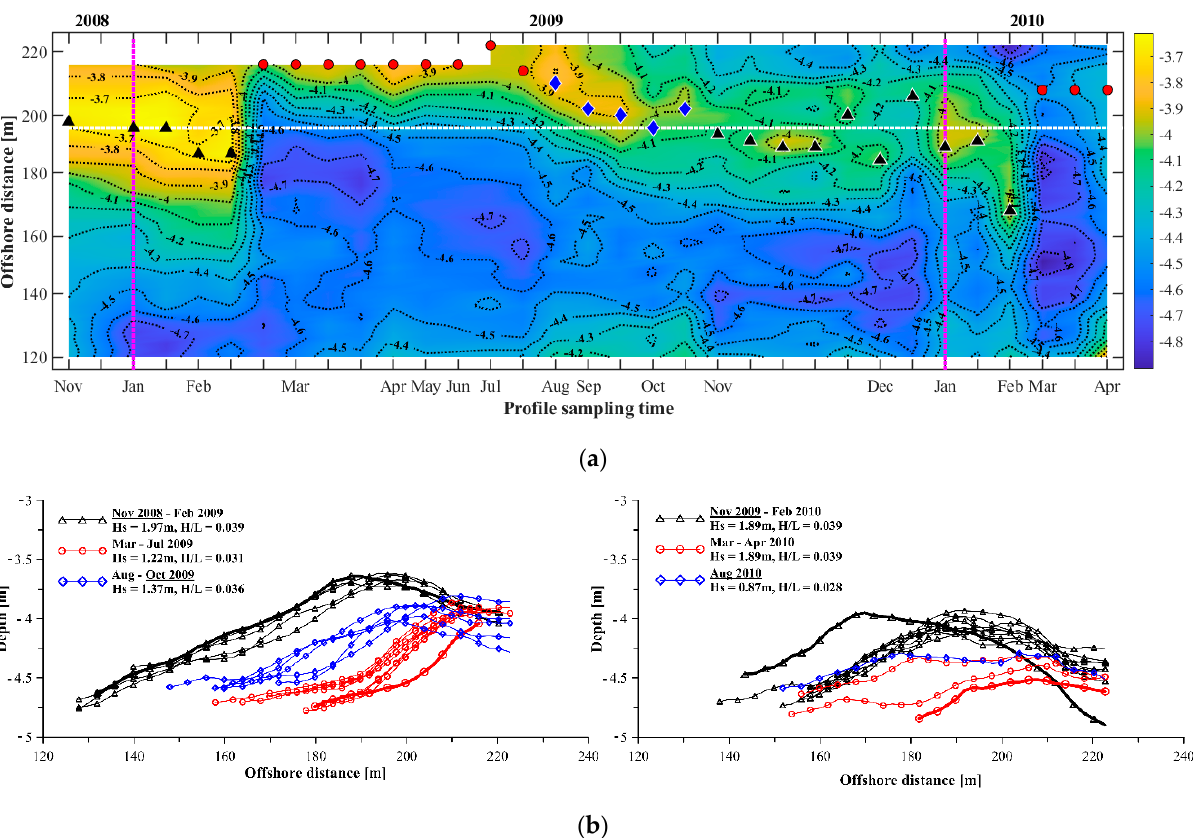
Figure 3. Intra-annual morphodynamics of the outer sand bar: ( a ) chronological seabed relief changes in November 2008–April 2010; colors and symbols of bar crest positions correspond to profile groups as described below in the caption text; vertical magenta lines—beginning of each year, horizontal white line—reference winter bar crest location defined from 2009 data; ( b ) outer bar profile envelopes of temporal variations (sweep zones) for November 2008–October 2009 (left panel) and November 2009–August 2010 (right panel), Hs and H/L—seasonally averaged monthly maximum values of the parameters at depth 4.4 m; black lines with triangles—winter pro-files, red lines with circles—summer profiles, and blue line with diamond—transitional profiles; heavy black line with triangles—last measured profile prior to the abrupt seaward bar shift, heavy red line with circles—first profile after the bar’s displacement to its summer